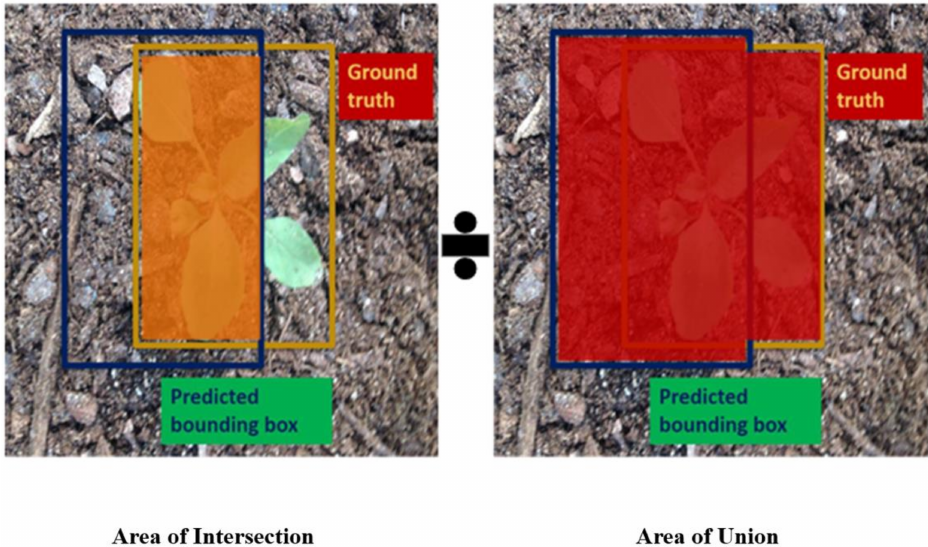
Figure 6. Illustration of the IoU on the dicot dataset